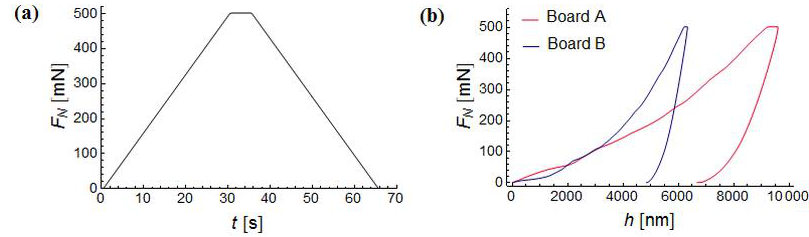
Figure 8. Applied nanoindentation grid.